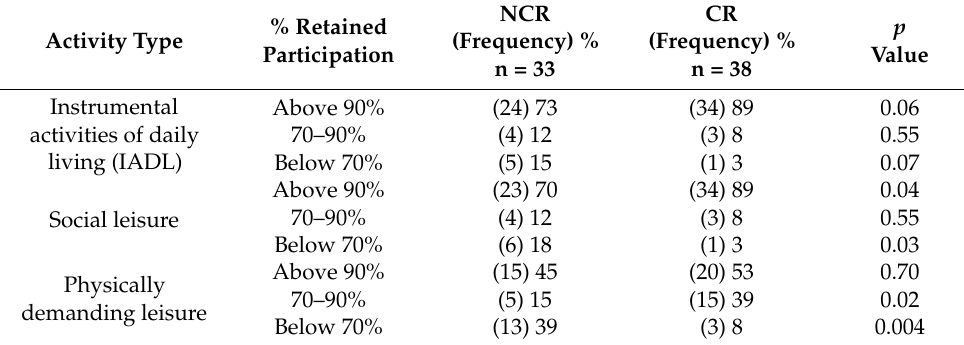
Table 3. Proportion of retained activity levels per